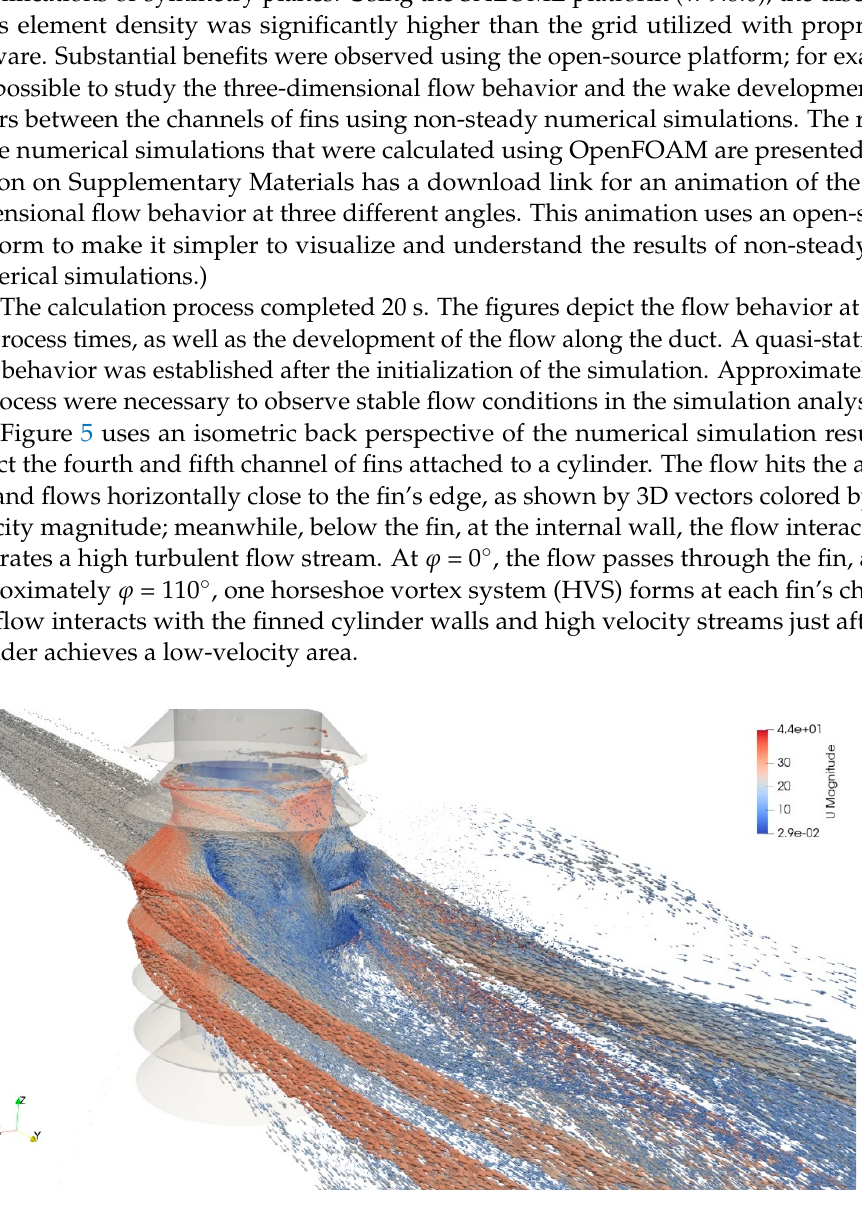
Figure 5. Isometric rear view with vectors colored by its velocity magnitude around the fourth and fifth fin of the cylinder.